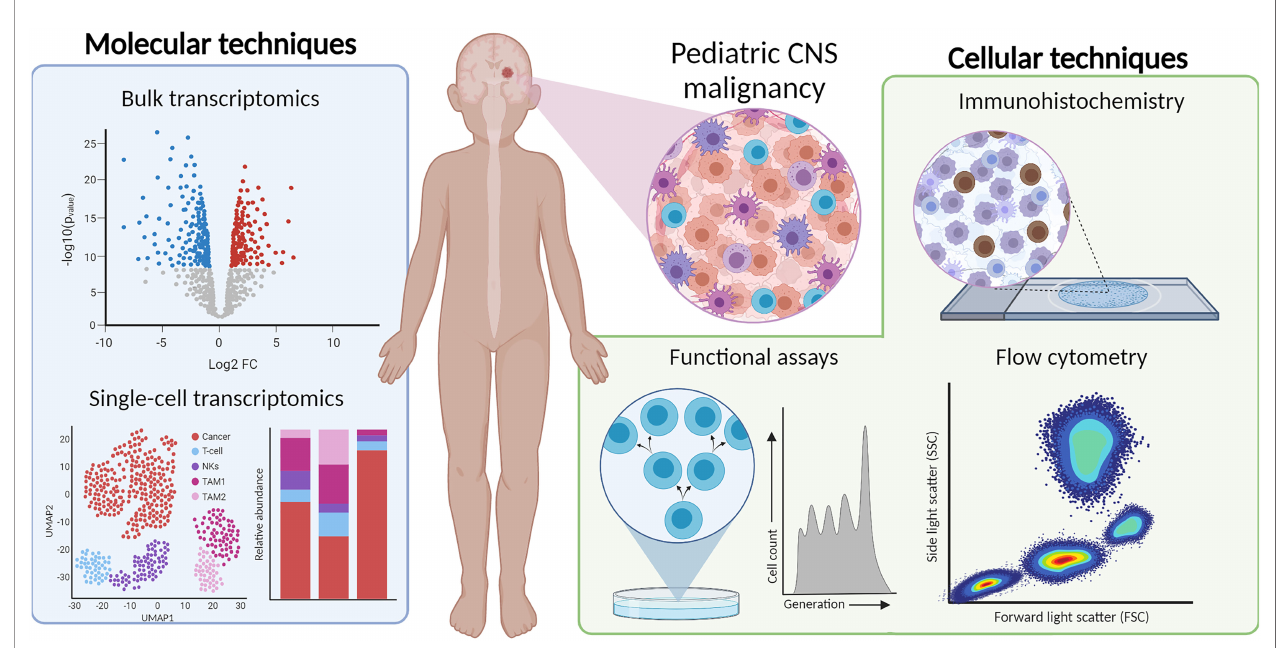
FIGURE 1 | Multi-dimensional immunophenotyping of TIME from tumor tissue using IHC, fl ow cytometry, bulk- and scRNA-seq, and functional